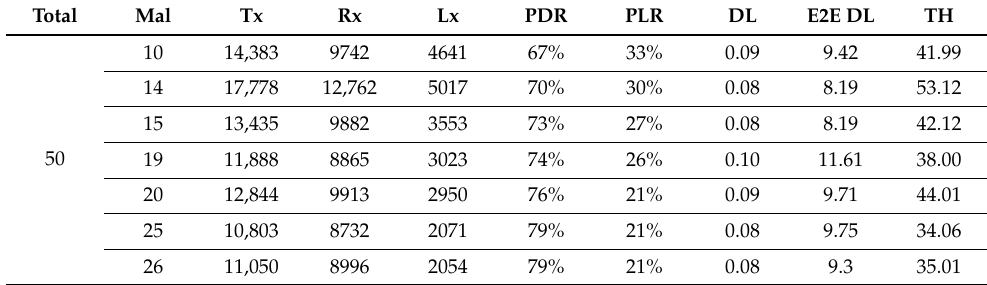
Table 5. The Stats of the Static Network Under